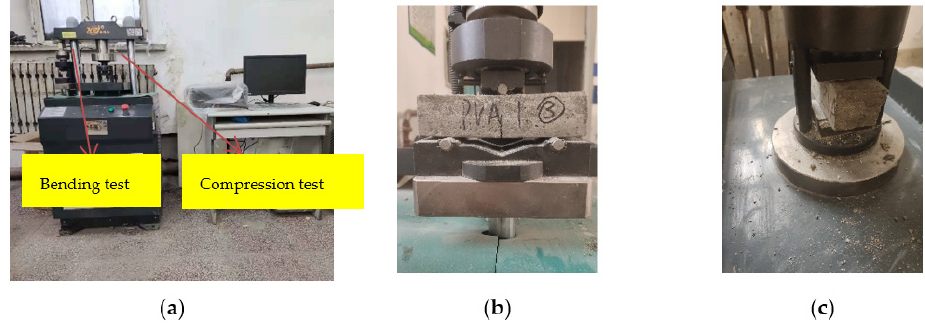
Figure 3. Mechanical test: ( a ) YAW-300H testing machine; ( b ) Bending test; ( c ) Compression test.